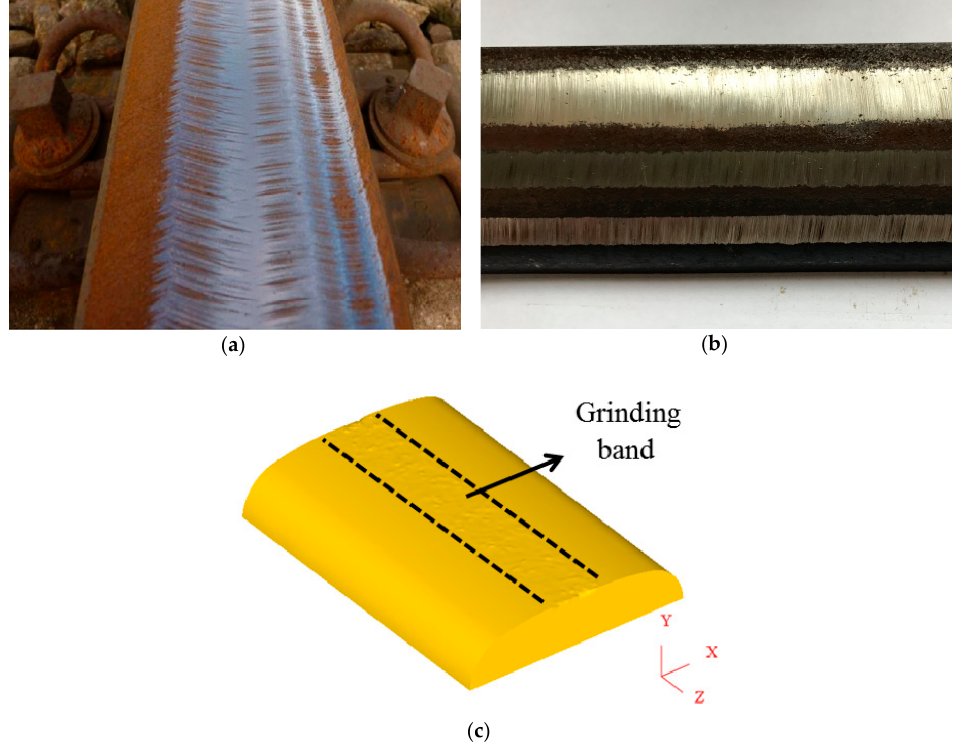
Figure 4. Verification of the grinding band between ( a ) the field, ( b ) the experiment and ( c ) the simulation.